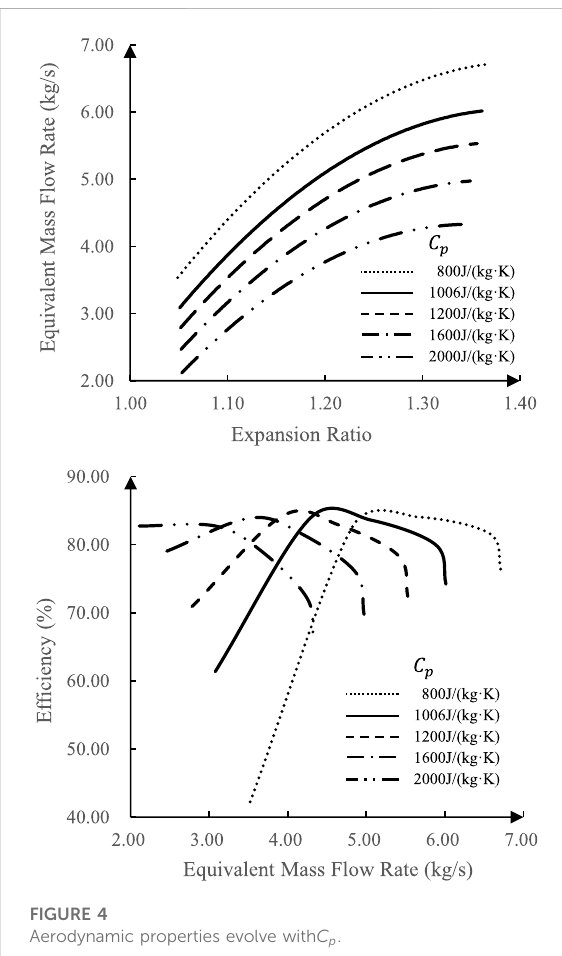
FIGURE 5 Aerodynamic properties evolve with γ